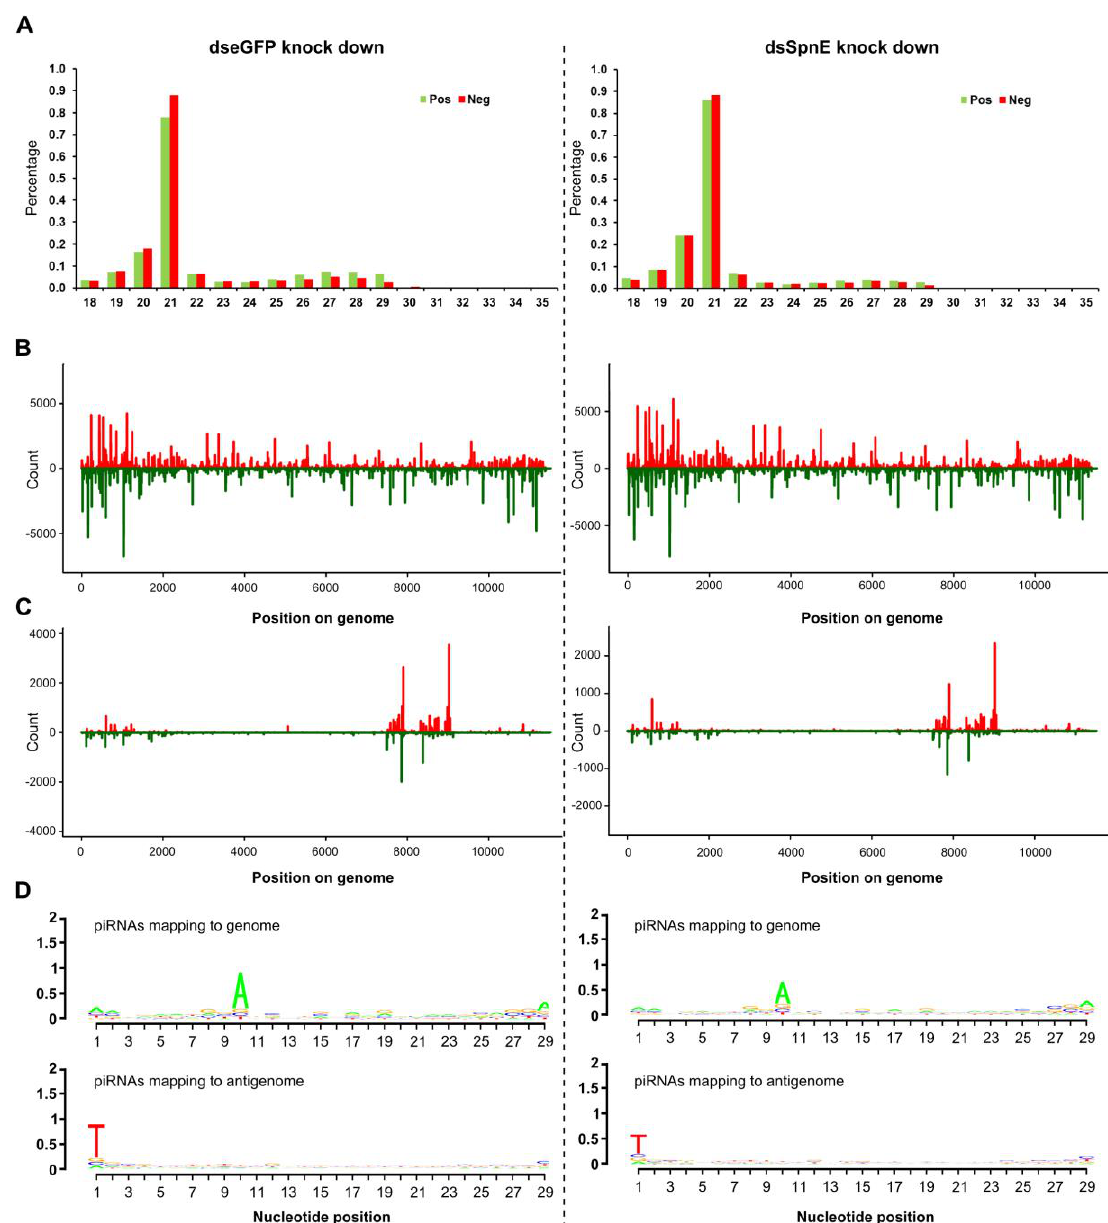
Figure 6. Analysis of SFV-specific small RNAs from Aag2 cells. dsRNAs were used to knock down eGFP (Left panel, as control) or SpnE (Right panel) in Aag2 cells. At 24 h pt cells were infected with SFV at an MOI of 10. At 48 hpi total RNA was isolated and small RNAs collected and sequenced. ( A ) Size distribution of small RNA sequences mapping to the SFV genome (red) or antigenome (green) (as percentage of total reads). Distribution of 21 nt ( B ) or 27 nt ( C ) long RNAs along the SFV genome (red, positive numbers on Y axis) or antigenome (green, negative numbers on Y axis); ( D ) relative nucleotide frequency and conservation per position of the 24- to 29-nt long piRNAs mapping to the SFV genome or antigenome; as DNA template was used for sequencing, U is represented by